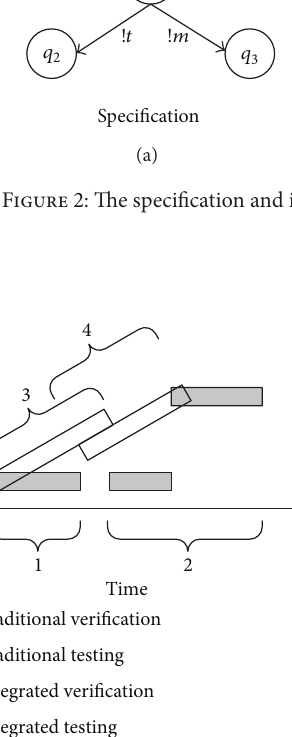
Figure 3: The iterative refinements in the integrated verification and testing